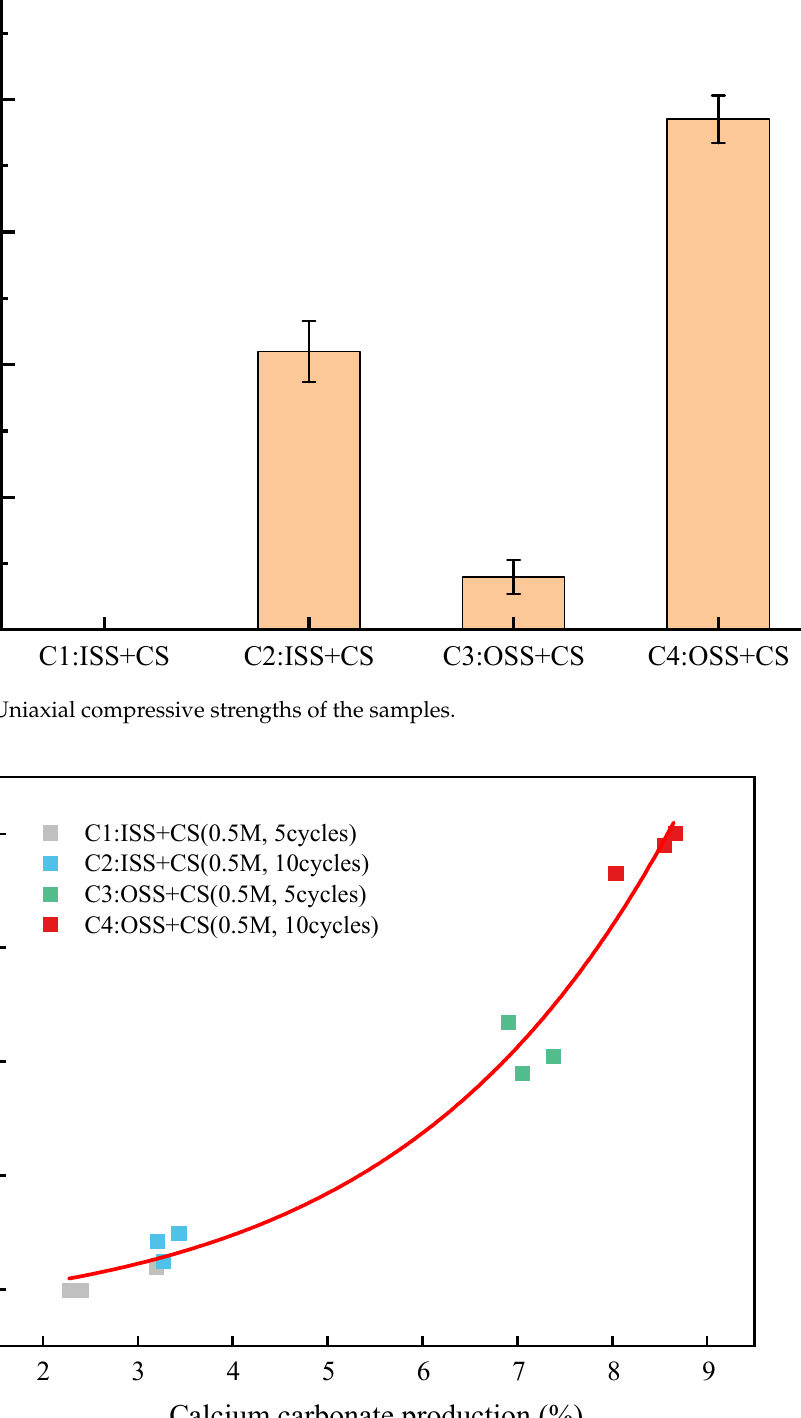
Figure 11. Relationship between calcium carbonate content and uniaxial compressive strength.